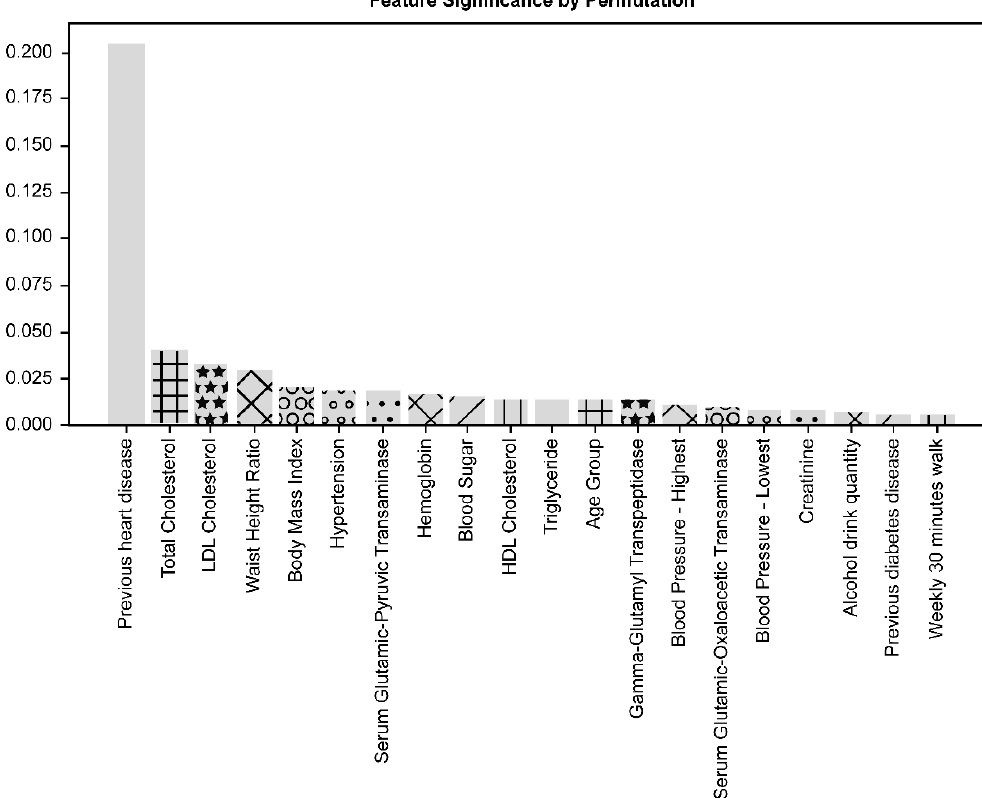
Figure 4. Importance analysis of contributing factors with the permutation importance method. As in the analysis of the feature importance method, previous CVD was the most important factor, followed by TC, LDL cholesterol, waist-to-height ratio, and body mass index.